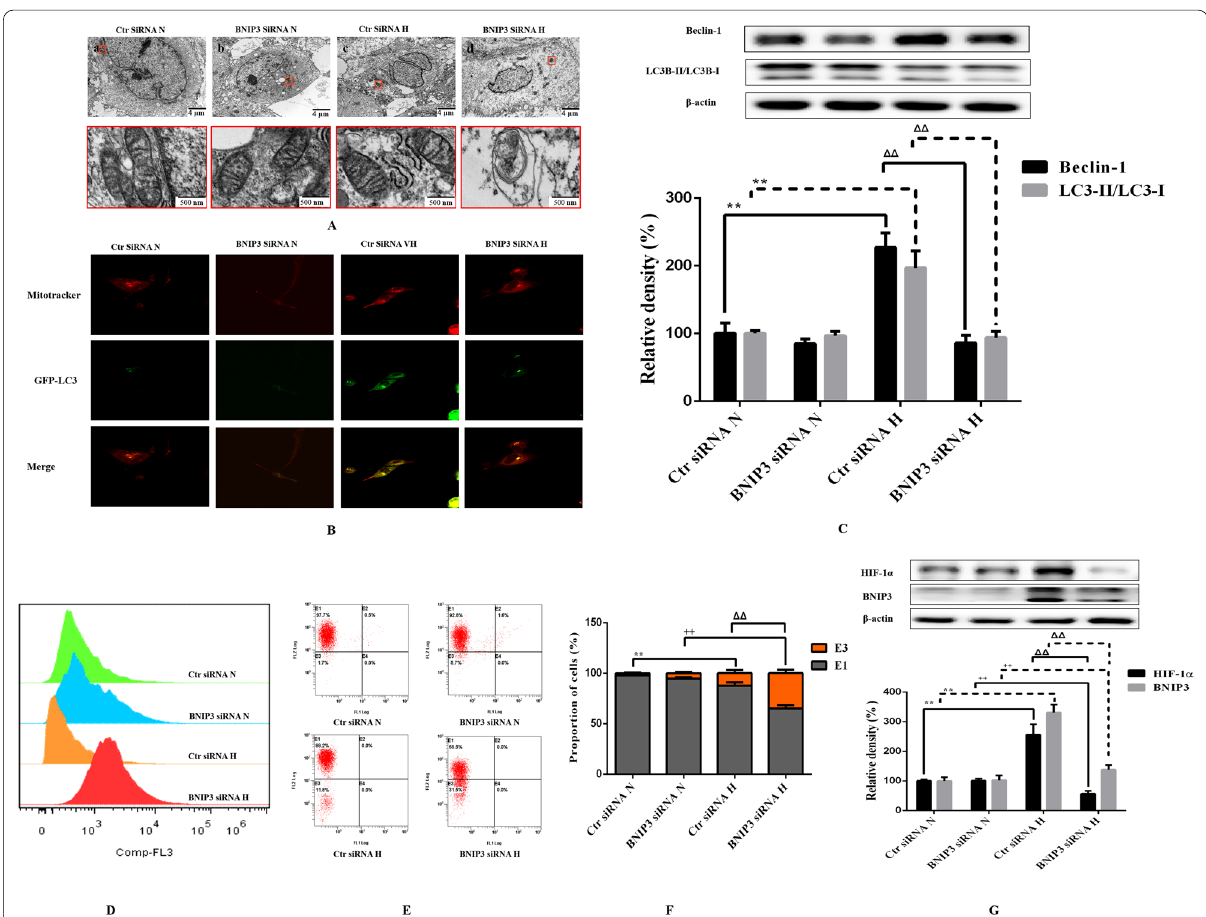
Fig. 6 Effects of low expression of BNIP3 on the mitophagy and oxidation indexes of RA-FLSs. A RA-FLSs were analysed by electron microscopy. B RA-FLSs were infected with EGFP-LC3 (Green) for 24 h and then exposed to 21% and 2% O 2 for another 24 h, after that, mitochondria were marked with Mitotracker (Red). Representative images are shown. C The expression of Beclin-1 and LC3 was analyzed by Western blot (mean from three independent experiments); D RA-FLSs were exposed to 21% O 2 or 2% O 2 for 24 h and assessed the ROS content by FCM using 10 μM CM-H2DCFDA as a ROS probe; E C-1 was used to detect the effect of hypoxia on MMP of RA-FLSs; F Histogram depicts the quantitative data from the JC-1 staining (mean SD, n 6 from three independent experiments); G The expressions of HIF-1α and BNIP3 in RA-FLSs after hypoxia for 24 h ± = were analyzed by Western blot (mean SD, n 6 from three independent experiments). # P < 0.05, ## P < 0.01 represents the comparison between Ctr ± = siRNA N and BNIP3 siRNA N; *P < 0.05, **P < 0.01 represents the comparison between Ctr siRNA N and Ctr siRNA H, + P < 0.05, ++ P < 0.01 represents the comparison between BNIP3 siRNA N and BNIP3 siRNA H, Δ P < 0.05, ΔΔ P < 0.01 represents the comparison between Ctr siRNA H and BNIP3 siRNA